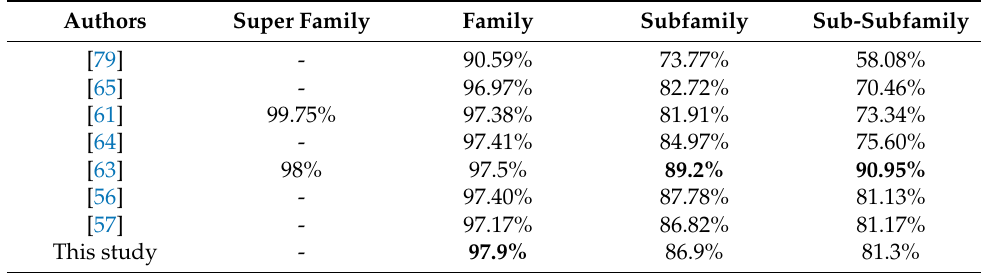
Table 8. Comparison of GPCR protein classification using the GDS